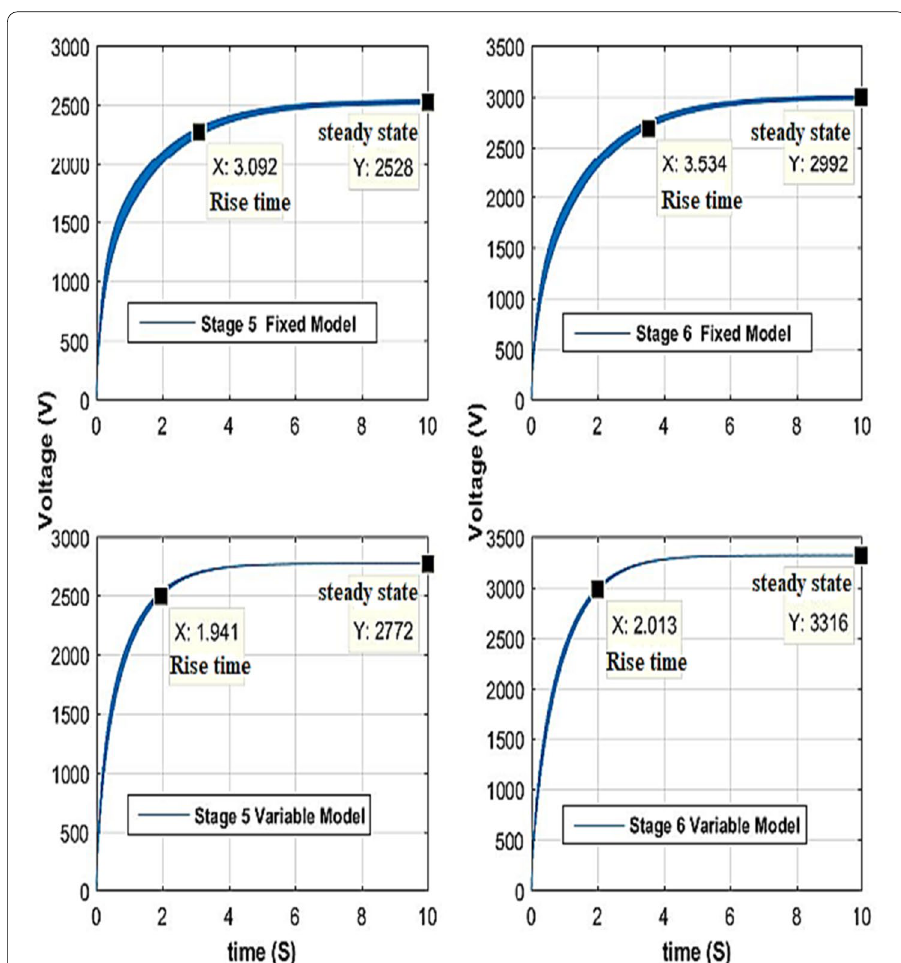
Fig. 8 Rising time, transient and steady state value of output voltage of stages five and six of both